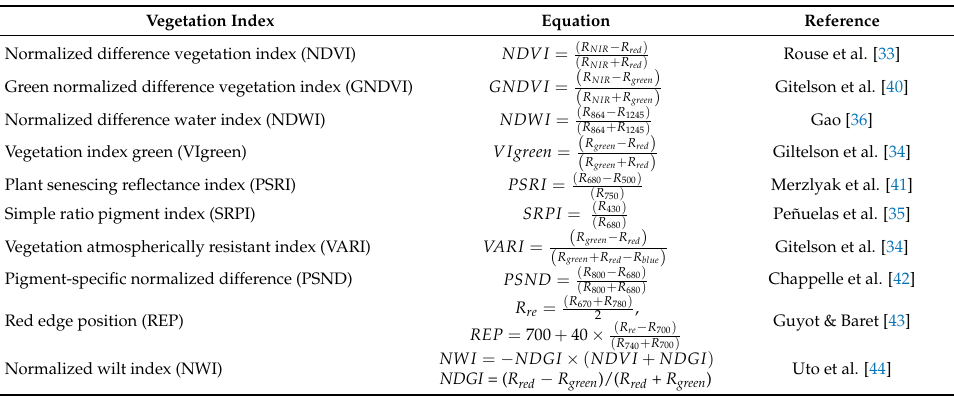
Table 1. Vegetation indices calculated from multispectral and hyperspectral